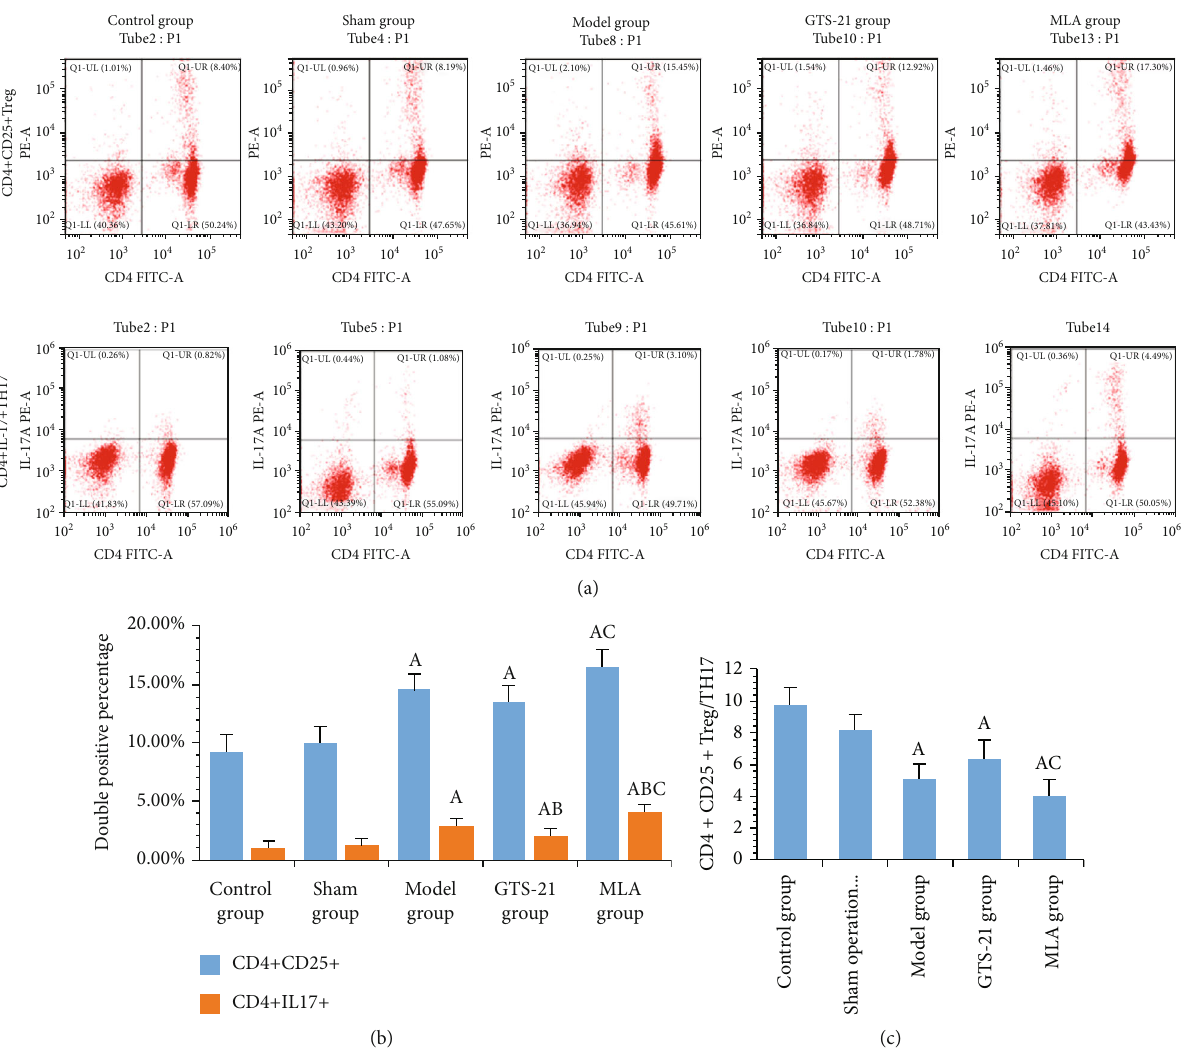
Figure 4: Study of the cholinergic anti-in fl ammatory pathway (CAP) on immune regulation. (a) Representative scatter plot images of fl ow cytometry of CD4+CD25+Treg and CD4+IL-17+TH17 lymphocyte among di ff erent groups. (b) Double positive percentage of CD4+CD25+Treg and CD4+IL-17+TH17 lymphocytes among di ff erent groups. (c) The ratio of CD4+CD25+Treg/TH17 among groups. CD4+CD25+Treg lymphocyte percentages of the model group, GTS-21 group, and MLA group were much higher than those of the control group. The P value and 95% CI were, respectively, 0.000, -7.893 ∼ -2.754; 0.002, -6.773 ∼ -1.634; and 0.000, -9.846 ∼ -4.707, and so were CD4+IL- 17+TH17 lymphocyte percentages; they were 0.000, -2.668 ∼ -1.279; 0.002, -1.851 ∼ -0.462; and 0.000, -3.858 ∼ -2.469. CD4+CD25+Treg and CD4+IL-17+TH17 lymphocyte percentages of the MLA group were much higher than those of the GTS-21 group. The P value and 95% CI were, respectively, 0.018, 0.504 ∼ 5.643; 0.000, 1.312 ∼ 2.701. A: P < 0 : 05 vs. control group; B: P < 0 : 05 vs. model group; C: P < 0 : 05 vs. GTS-21